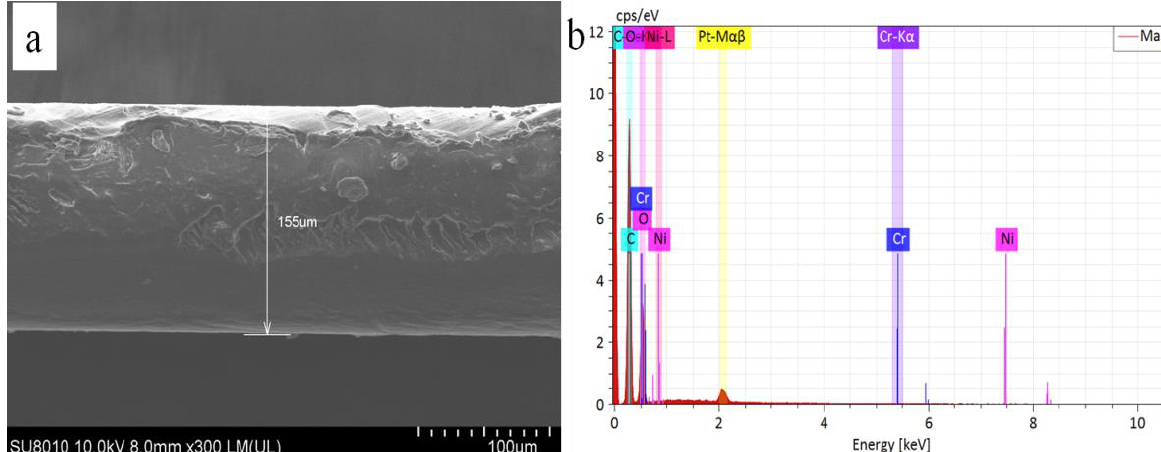
Figure 1. SEM image ( a ) and EDAX ( b ) of PLLA film. Table 1. Atomic contents of elements.